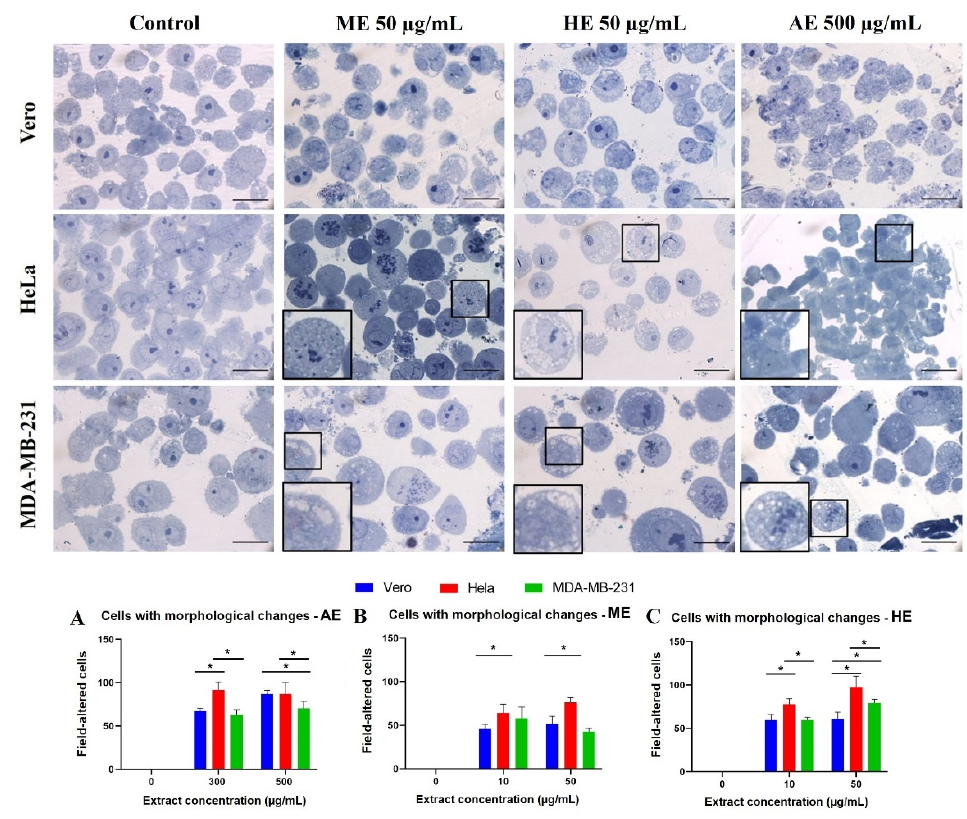
Figure 9. Evaluation of morphological changes in semi-thin sections stained with toluidine blue obtained from cells treated for 24 h with A. monostachya extracts. Note that upon exposure to the extracts, changes in nuclear morphology (condensation and displacement of chromatin towards the periphery), and cytoplasmic morphology (accumulation of vacuoles) were observed. Alterations in cell size were also observed, especially in tumor cells treated with HE. The HeLa cells showed more evident changes vs. the Vero cells followed by the MDA-MB-231 cells. The amplifications show changes in nuclear morphology and cytoplasm. Scale bar = 20 µm. Quantization of cells with morphological alterations related to cell death after exposure to A. monostachya extracts. Vero (blue bar), HeLa (red bar), and MDA-MB-231 (green bar) both after exposure to concentrations of 0, 10, 50, 300, and 500 µg/mL of AE ( A ), ME ( B ), and HE ( C ). n = 8. * p < 0.05, Tukey’s multiple comparison test vs. Vero cells.